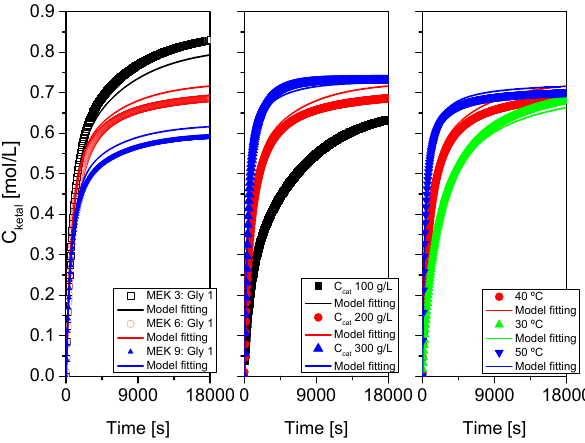
Figure 17. Fit of the proposed kinetic model to all data from system 2 (MEK + glycerol). Points correspond to the experimental data while lines show the fit of the model to such data.